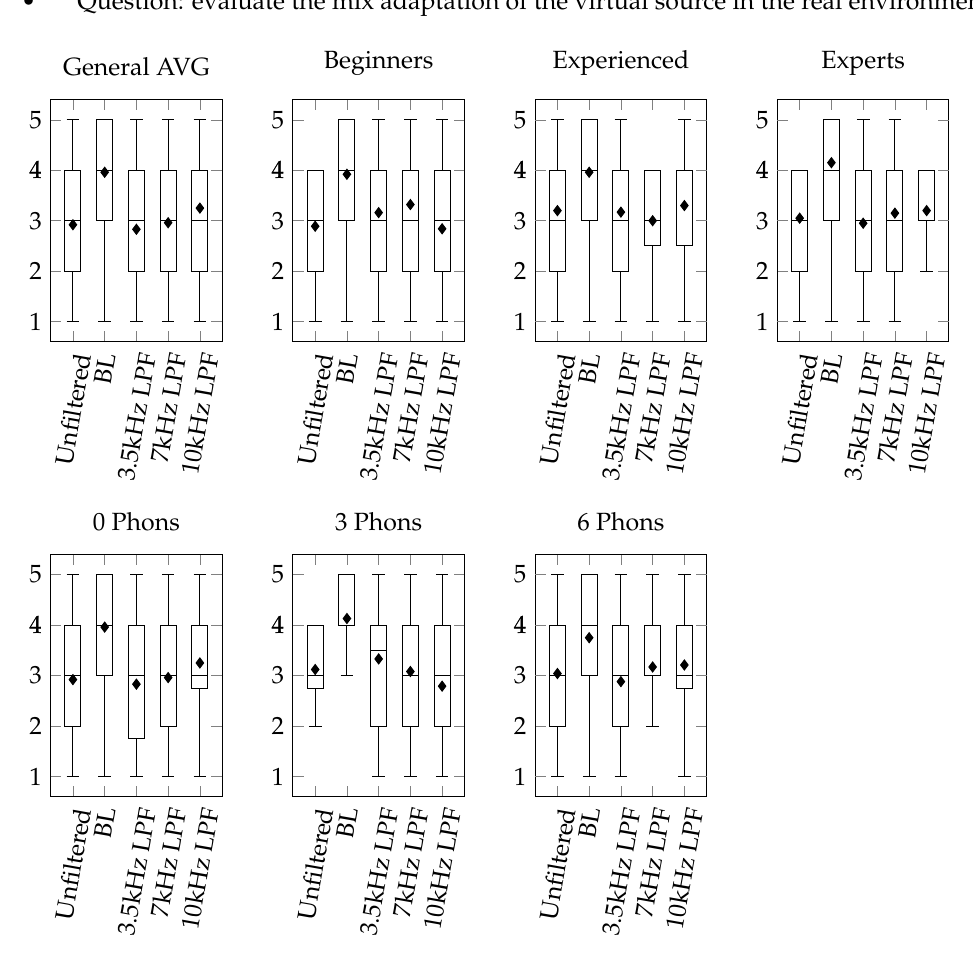
Figure 16. MUSHRA